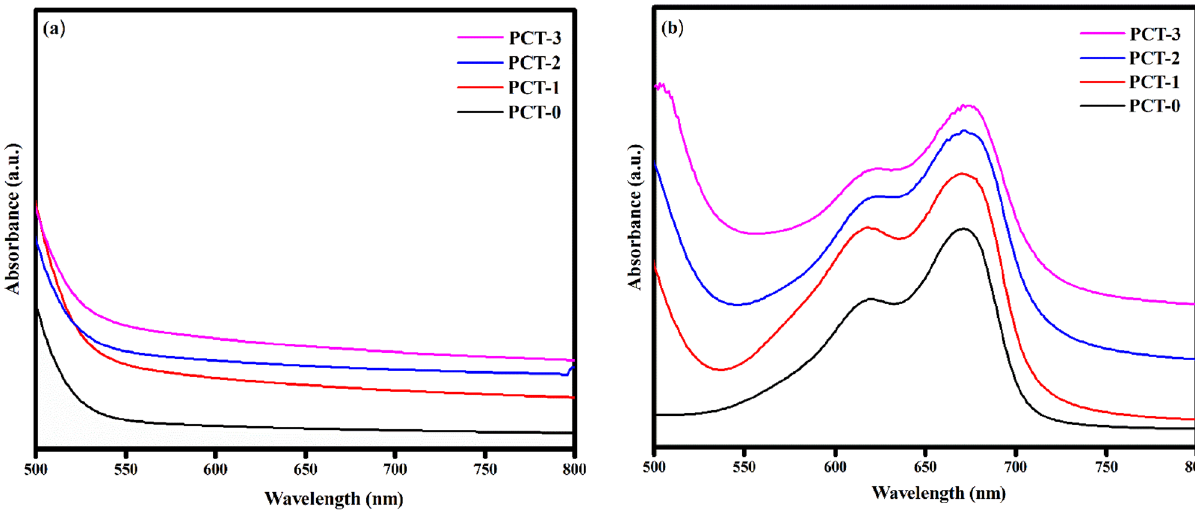
Figure 4. UV–Vis spectra of PVA/CMC/TUR films: ( a ) before and ( b ) after adsorption of